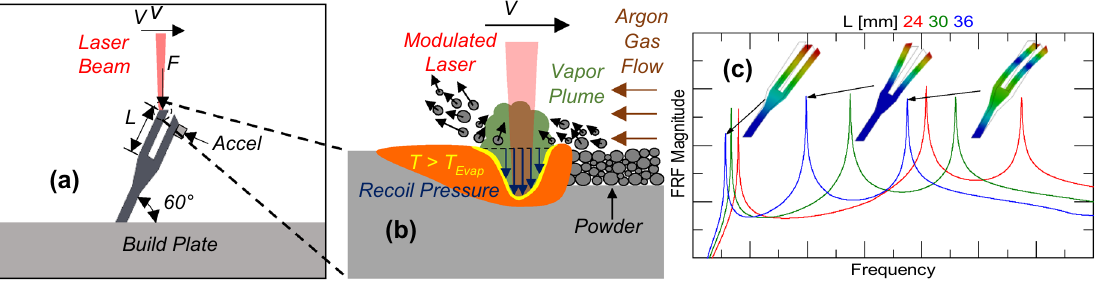
Figure 1. Illustrations of (a) laser excitation of tuning fork with accelerometer (Accel) mounted on tuning fork prong, (b) laser interaction with powder on top of tuning fork during laser excitation, and (c) example FRFs and mode